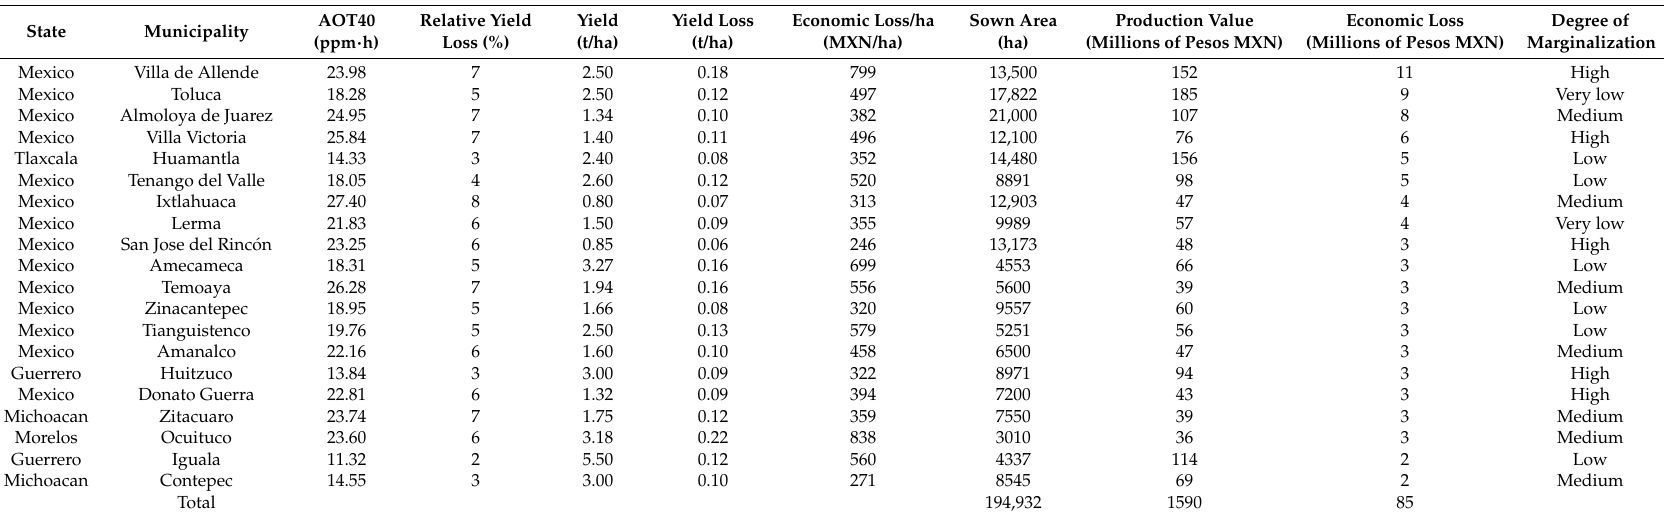
Table 3. Results for 2011 in the 20 municipalities most affected in terms of maize production, showing the input values and the results of the application of Equations (1)–(3) in the geographic information system